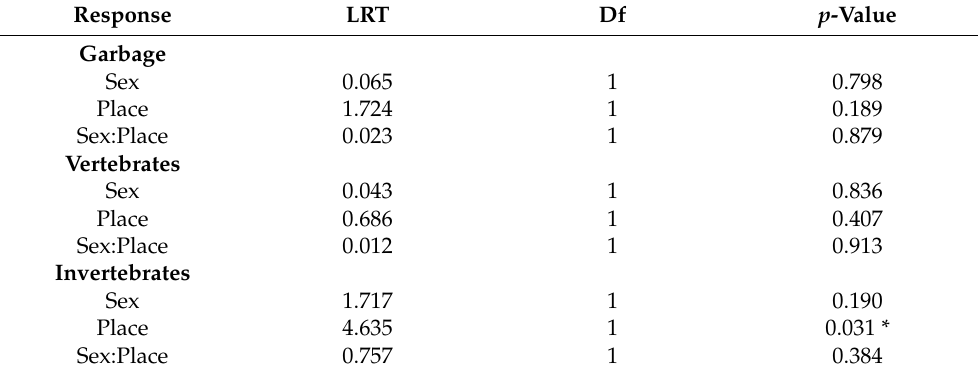
Table 1. Likelihood-ratio tests comparing the percentage occurrence of each food category ingested by female and male coatis ( Nasua nasua ) in two different parks (PMM and PNC). Sex—male and female; Place—PMM and PNC. * Significant p